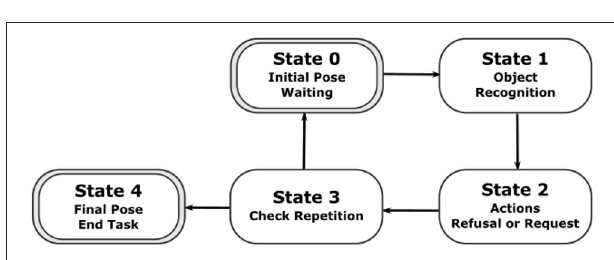
FIGURE 9 | A diagram illustrating the five states of the state machine developed specifically to perform our behavioural task.